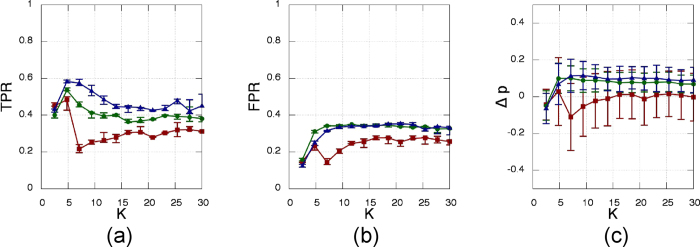
Same as in Fig. 3 but for Yi time-series.